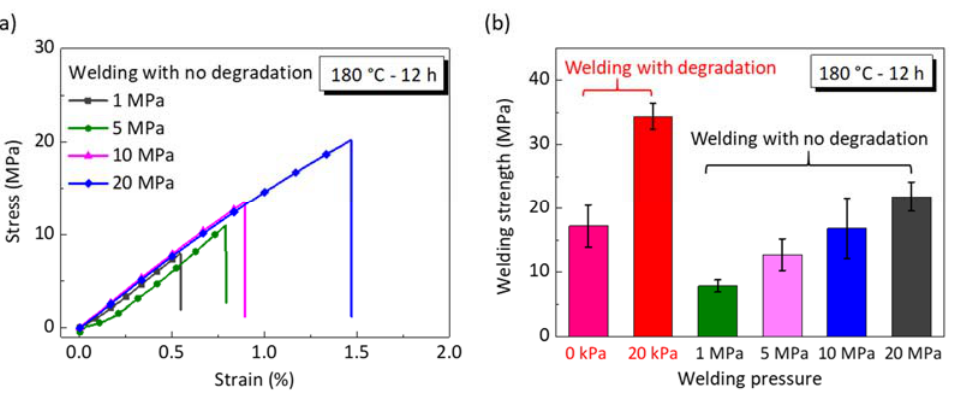
Figure 7. Comparison of the welding performance of epoxy vitrimer using hot-press welding and solvent-assisted welding. ( a ) Stress–strain curves of hot-press welding. ( b ) Welding strength of solvent-assisted welding and hot-press welding. The welding time and temperature are 12 h and 180 °C, respectively. Each data point represents the mean and stands deviation of three measurements.